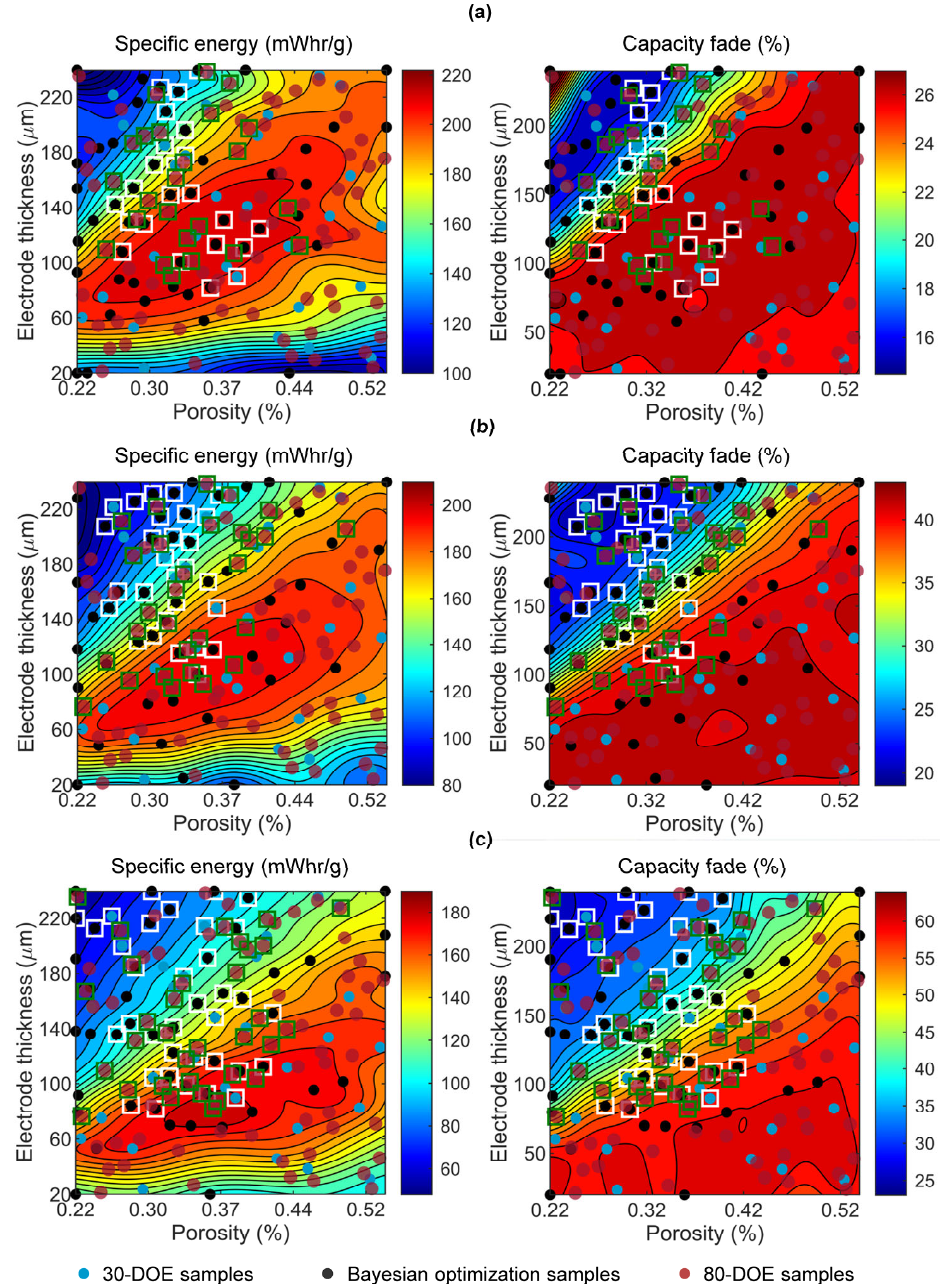
Figure 9. Gaussian process predictions of the specific energy and capacity fade for charge–discharge scenarios: ( a ) 0.7 C charge–0.23 C discharge; ( b ) 1.2 C charge–0.23 C discharge; ( c ) 3 C charge–0.23 C discharge. The blue dots are the initial 30 DOE samples, the black dots are the 50 Bayesian optimization samples, the red dots are the 80 DOE samples. The designs enclosed in white and green squares are the optimal designs from Bayesian optimization and the 80 ‐ sample DOE, respectively.